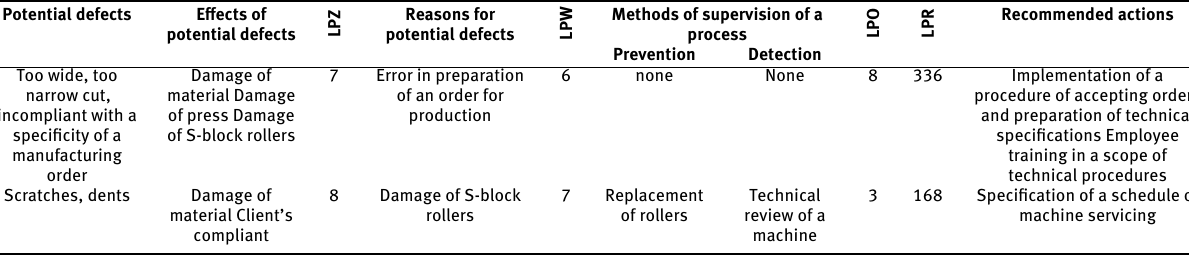
Table 4: Results of FMEA analysis for a procedure of cutting Potential defects